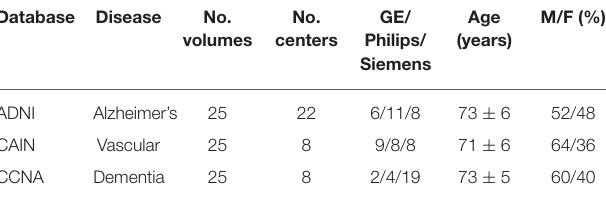
TABLE 2 | Data summary of sampled ground truth volumes. Database Disease